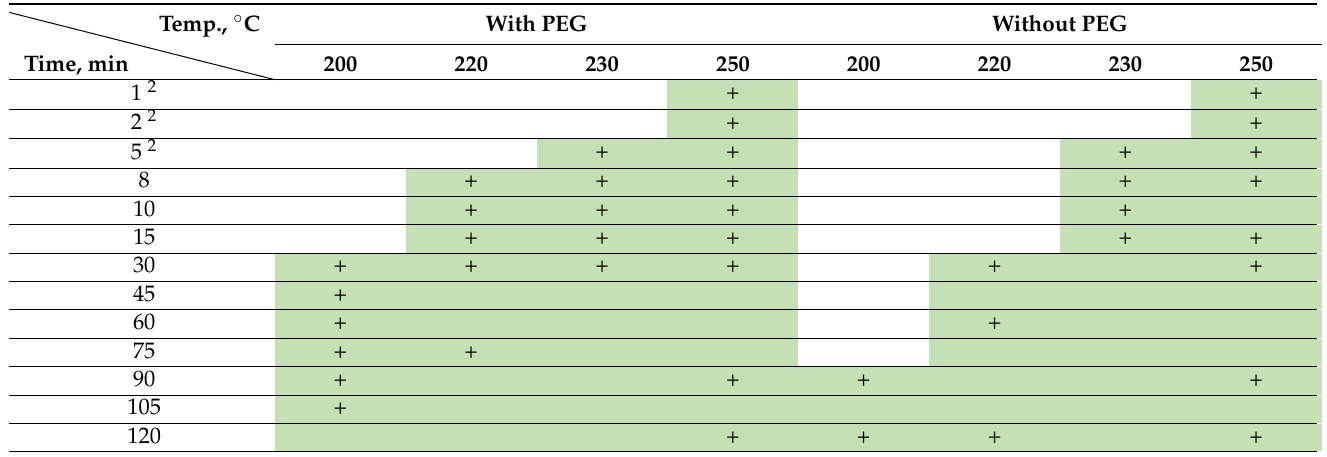
Table 1. Microwave-assisted solvothermal synthesis of Fe 3 O 4 particles with and without PEG in the synthesis mixture 1